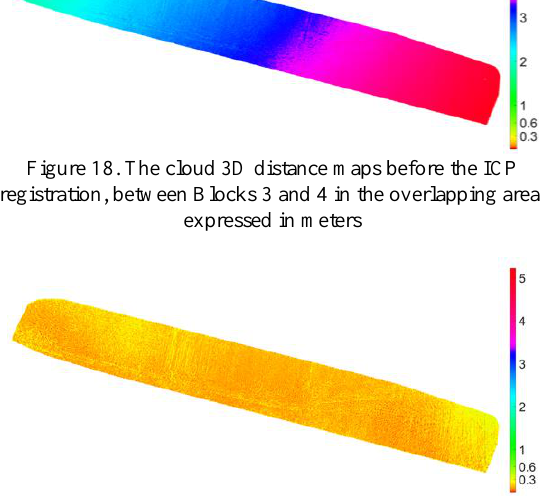
Figure 19. The cloud 3D distance maps after the ICP registration, between Blocks 3 and 4 in the overlapping area, expressed in meters